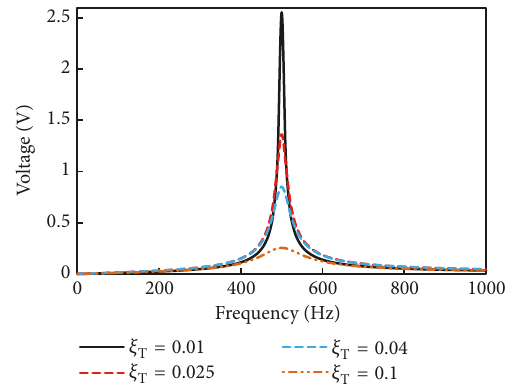
Figure 8: Open circuit output voltage of the simulated harvester at different values of total damping ratio 𝜉 T .